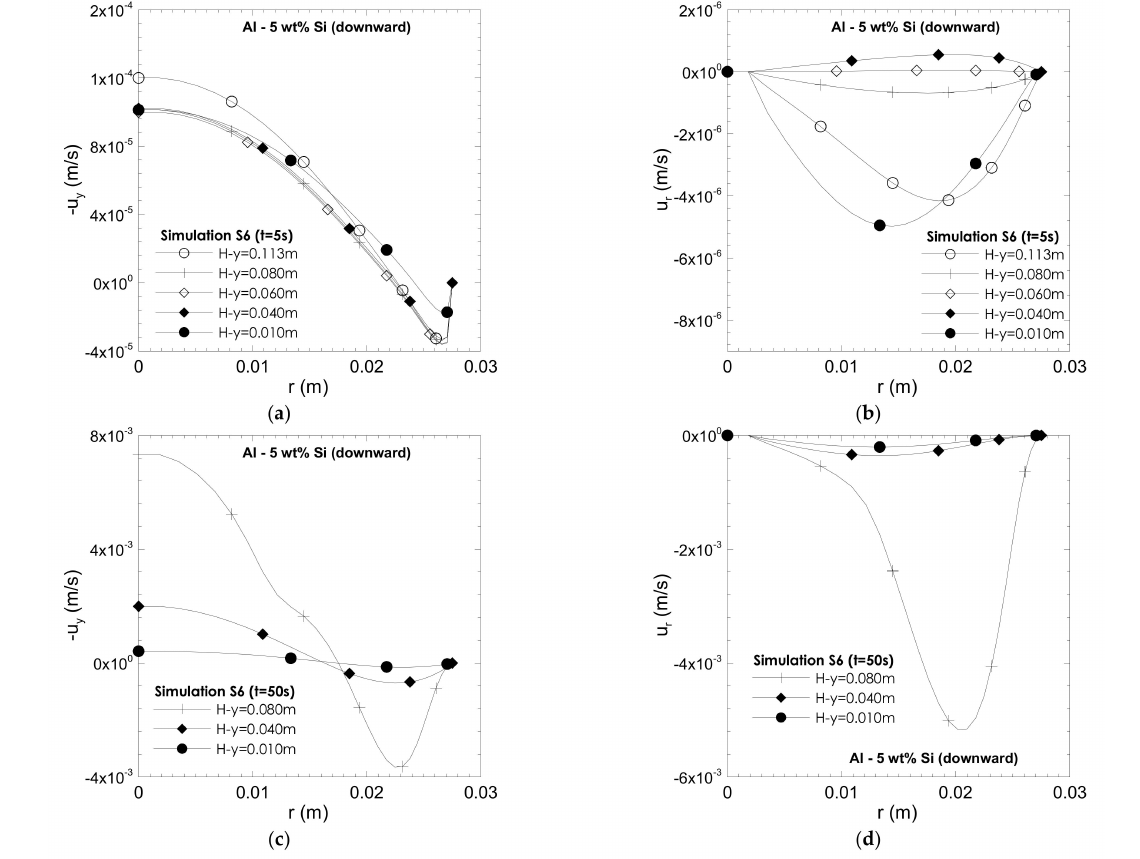
Figure 13. Flow velocity distribution at various locations of y during solidification for simulation S6 with effect of undercooling. ( a ) u y at t = 5 s; ( b ) u r at t = 5 s; ( c ) u y at t = 50 s; ( d ) u r at t = 50 s.